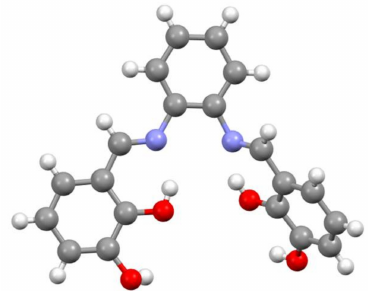
Figure 4. Crystal structure of the symmetric ligand SYML2. Carbon: gray. Hydrogen: white. Oxygen: red. Nitrogen: